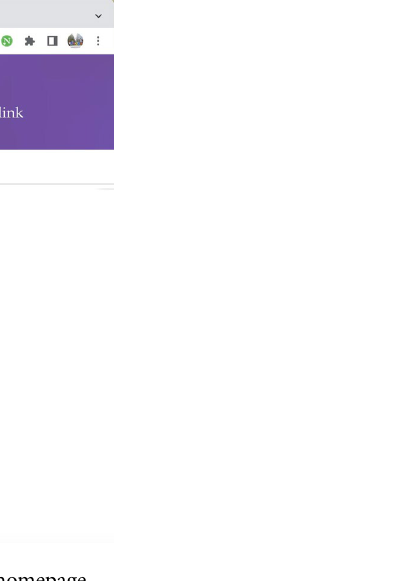
Figure 6. Web implementation of the application